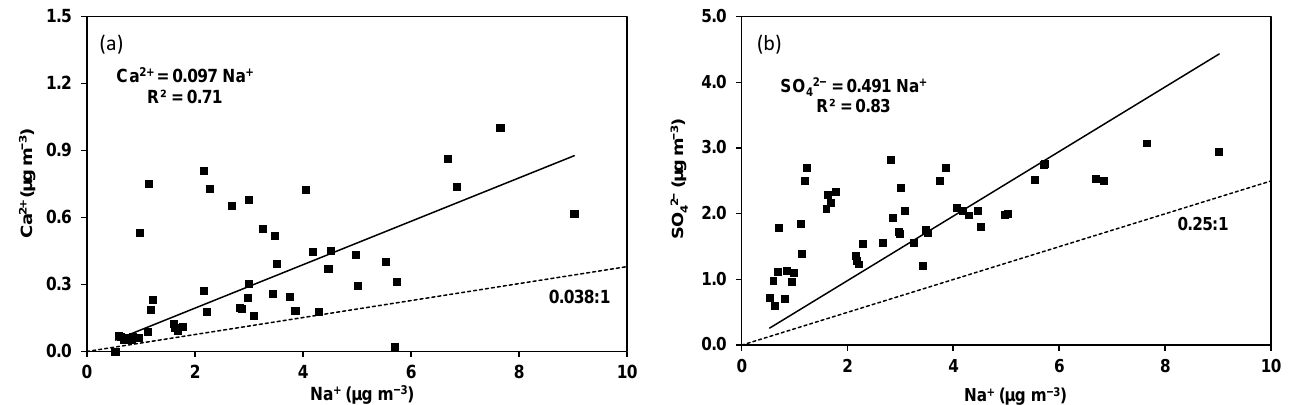
Figure 6. Correlations between: ( a ) Ca 2+ and Na + , ( b ) SO 42− and Na + . The dashed lines indicate ion ratios in fresh seawater.